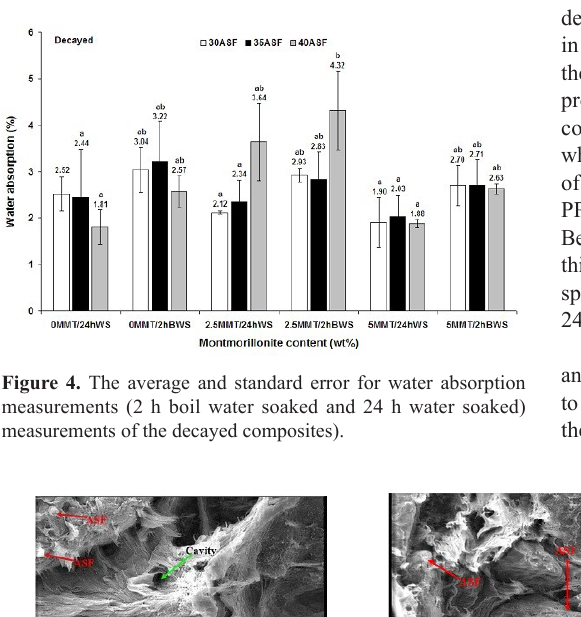
Figure 3. The average and standard errors for the water absorption (2 h boil water soaked and 24 h water soaked) measurements of the un-decayed composites).